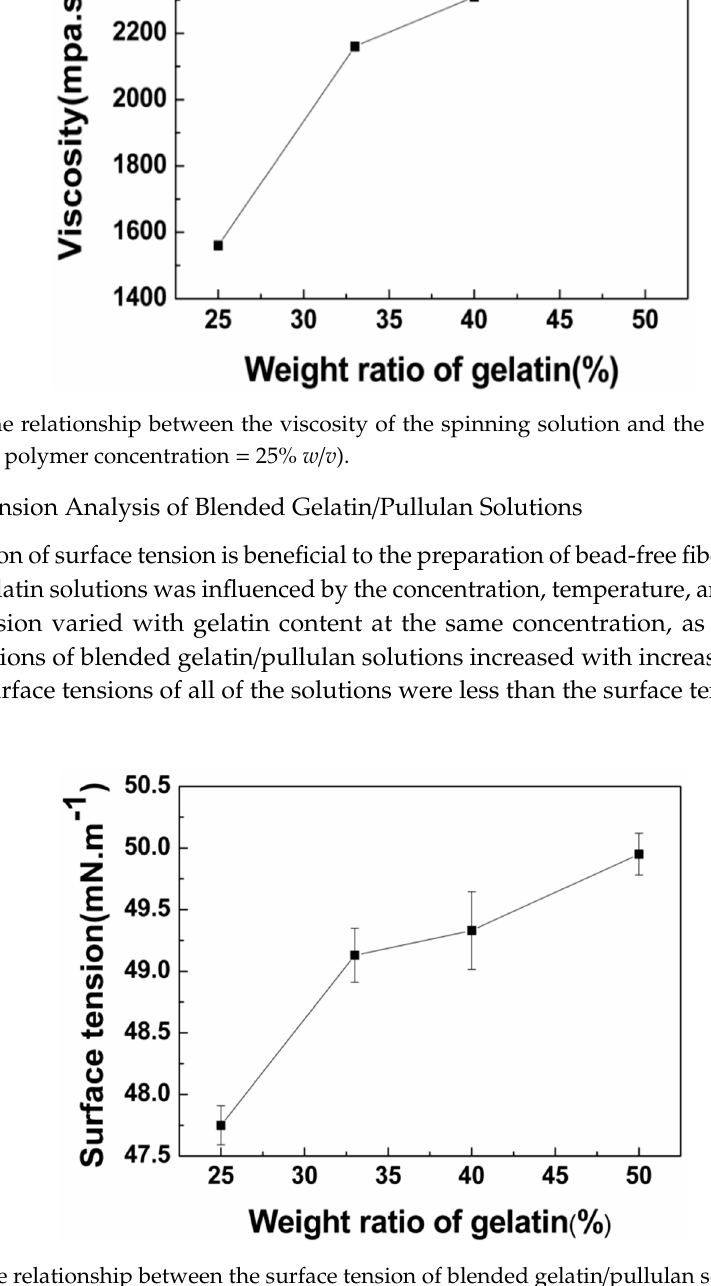
Figure 2. The relationship between the surface tension of blended gelatin / pullulan solutions and the weight ratios of gelatin (total polymer concentration = 25% w / v ).